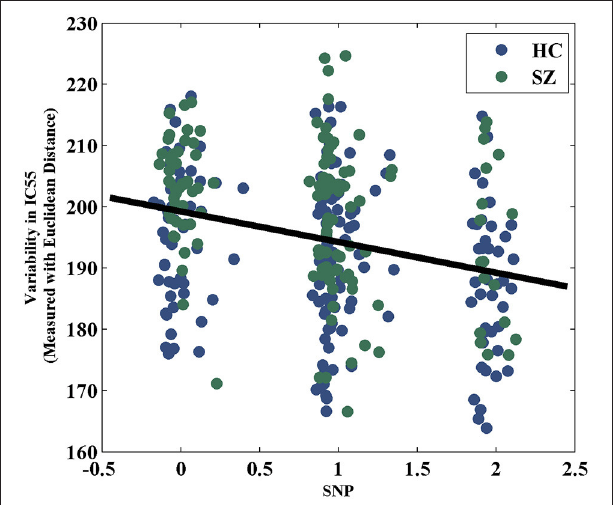
FIGURE 2 | Spatial maps and boxplots of components showing significant group differences in RSN variability measured with Euclidean Distance.